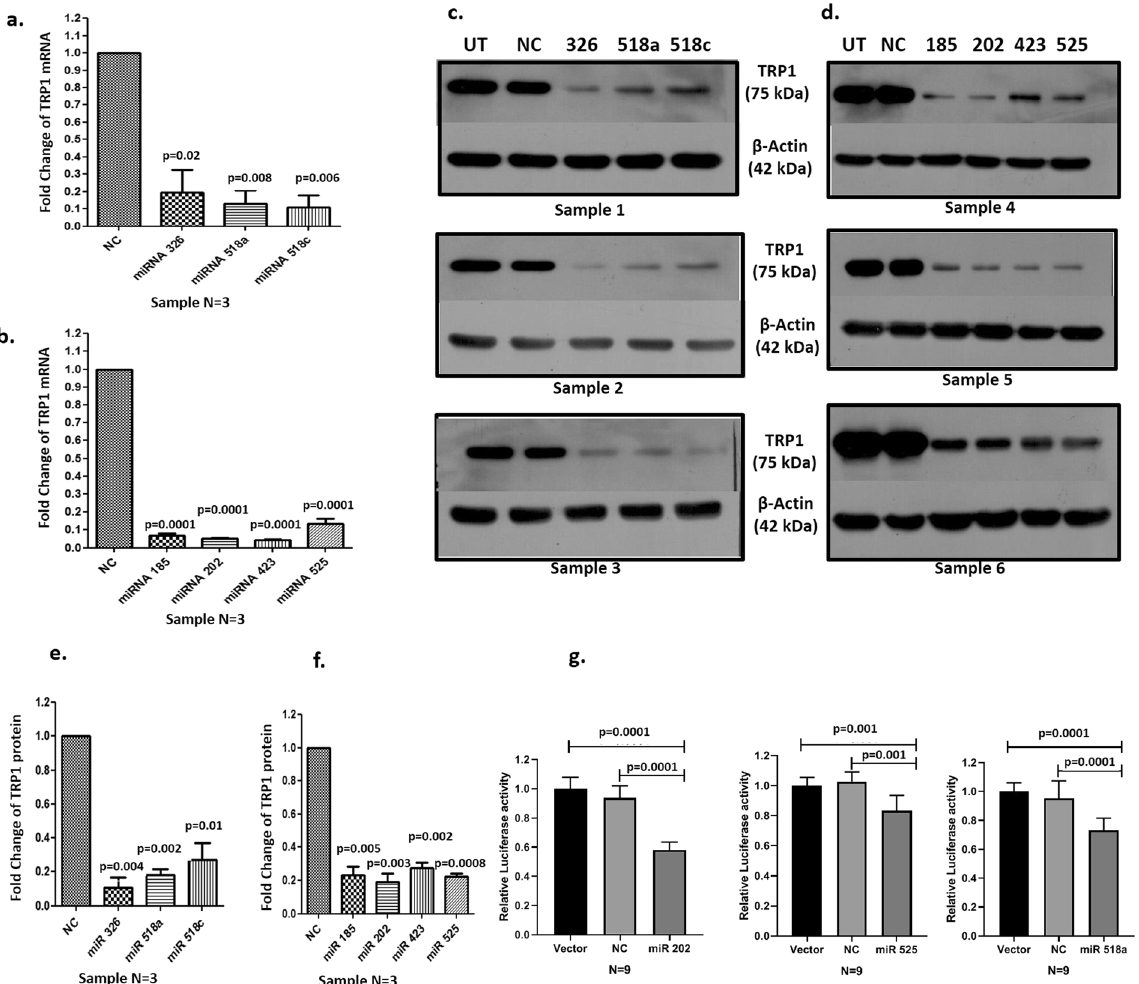
Figure 4. Downregulation of Tyrosinase related protein 1 (TRP1) by selected miRNA at mRNA and protein levels. ( a ) TRP1 mRNA profiling was done by qPCR and normalized with NC (negative control i.e., scrambled control). Expression of TRP1 in keratinocytes at mRNA level after transfection with pre-miR-326, pre-miR- 518a-5p and pre-miR-518c, ( b ) Transcriptional expression of TRP1 in keratinocytes after transfection with pre-miR-185, pre-miR-202-3p, pre-miR-423-3p and pre-miR-525-5p ( c ) Western blot of TRP1 expression after transfection with pre-miR-326, pre-miR-518a-5p, pre-miR-518c. UT is Untransfected control. Full gel pictures are shown in Supplementary Fig. 12. ( d ) Western blot of TRP1 expression after transfection with pre-miR-185, pre-miR-202-3p, pre-miR-423-3p and pre-miR-525-5p. Full gel pictures are shown in Supplementary Fig. 13. ( e ) Densitometric analysis of TRP1 protein expression in pre-miR-326, pre-miR-518a-5p, pre-miR-518c transfected keratinocytes after normalization with β - Actin, ( f ) Densitometric analysis of TRP1 protein expression in pre- miR-185, pre-miR-202-3p, pre-miR-423-3p and pre-miR-525-5p transfected keratinocytes after normalization with β -Actin (N = 3), ( g ) Target validation assay results showing significantly reduced relative luciferase activity of 3'UTR clones transfected with pre-miR-202-3p, pre-miR-518a-5p and pre-miR-525-5p. All the bars showing reduced expression are depicted as mean ± standard error of mean